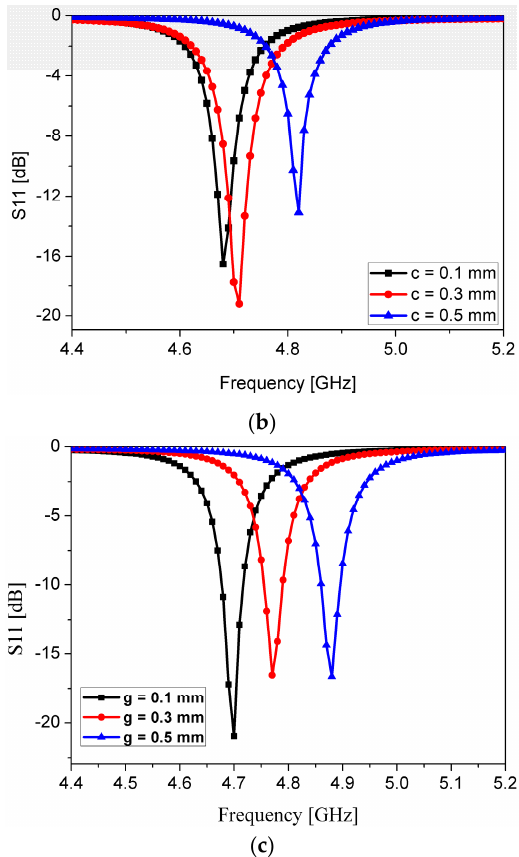
Figure 3. Simulated S 11 of the CSRR-loaded patch resonator at different ( a ) slot length of a , ( b ) slot width of c , and ( c ) gap of g .